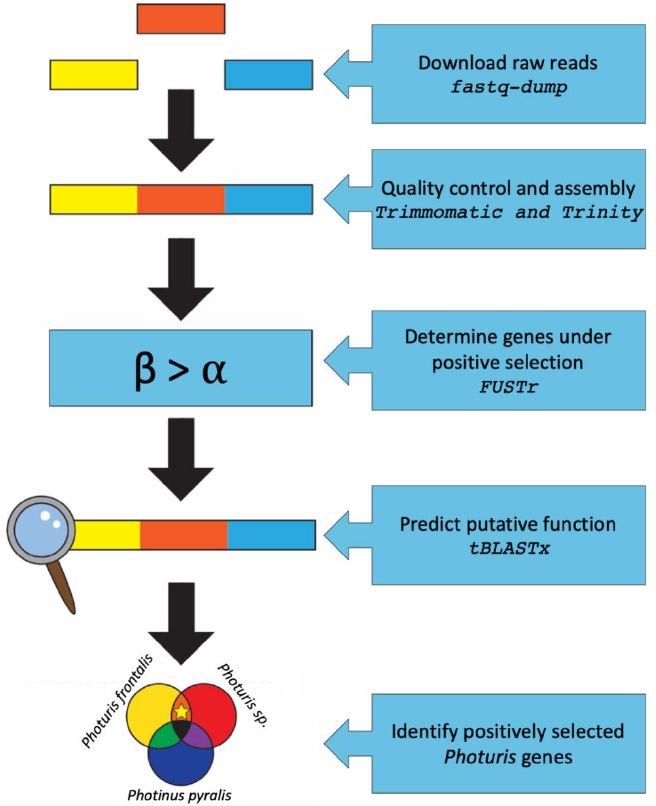
Figure 1. Graphical workflow of computational methods. The specific programs used for each step are shown in italic Courier font. Colored bars represent raw reads that are first downloaded, and then assembled into contigs and quality trimmed. The assemblies are assessed for gene families under positive selection using the posterior probability that β > α . The putative function of the positively selected genes is determined using a homology search. We are interested in the genes involved in predatory behavior, which are in the Photuris frontalis and Photuris sp. comparison, represented by a